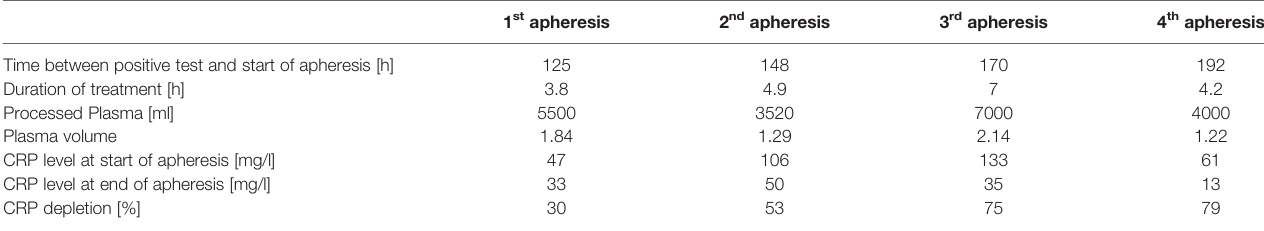
TABLE 2 | Apheresis speci fi cations.